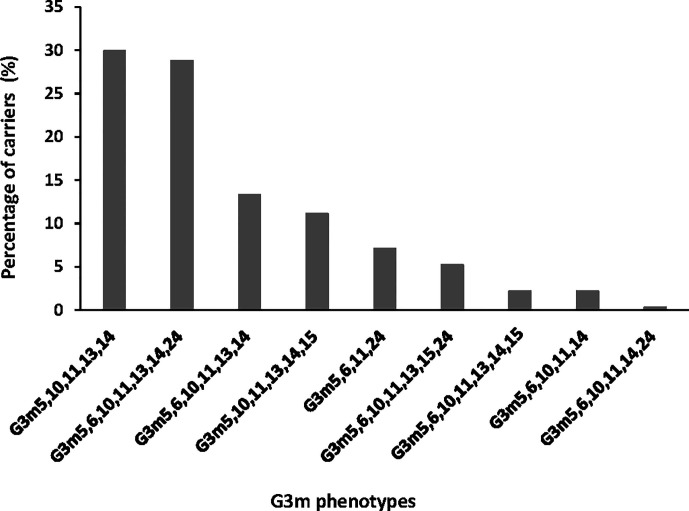
Distribution of G3m phenotypes in the study group.